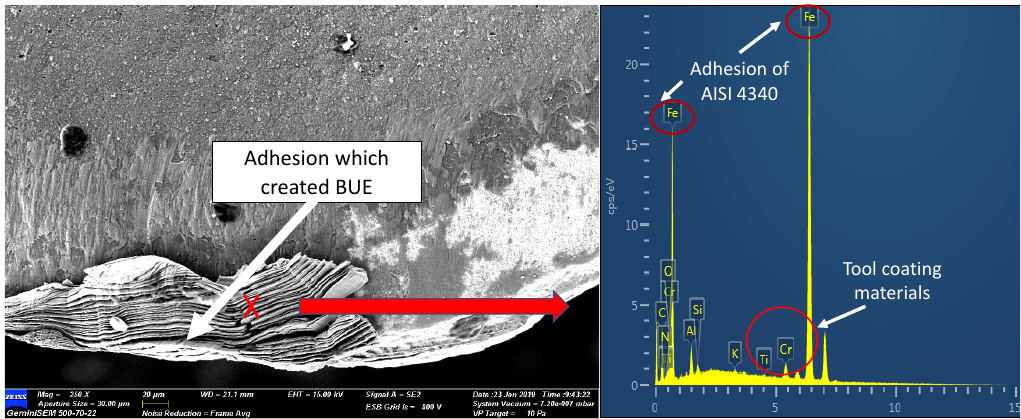
Figure 4. Adhesion wear on the rake face and EDAX analysis: Experiment 6. Figure 4